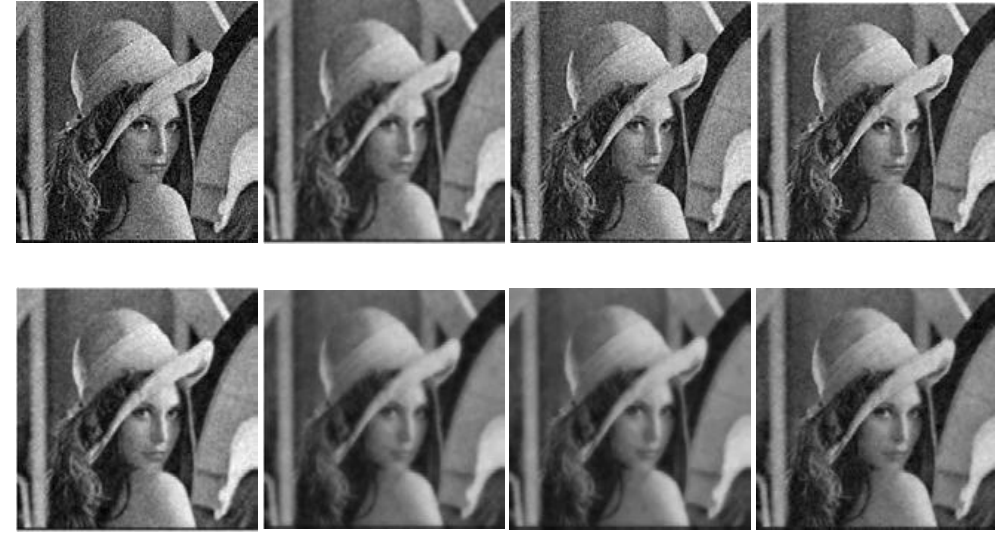
Fig. 5. The denoising effect with different methods on Lena image. (a) noisy (b) BM3D (c) DnCNN (d) MSRResNet-GAN (e)